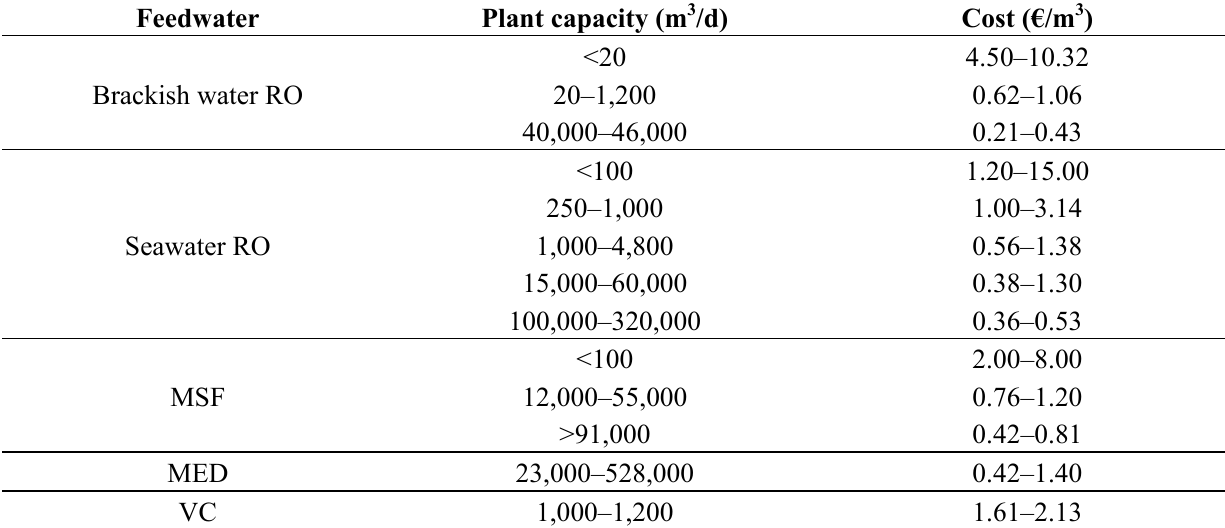
Table 5. RO desalination production cost compared to thermal desalination technologies cost, per feeding water and production capacity. MED: multi-effect distillation; and VC: vapor compression. Adapted from